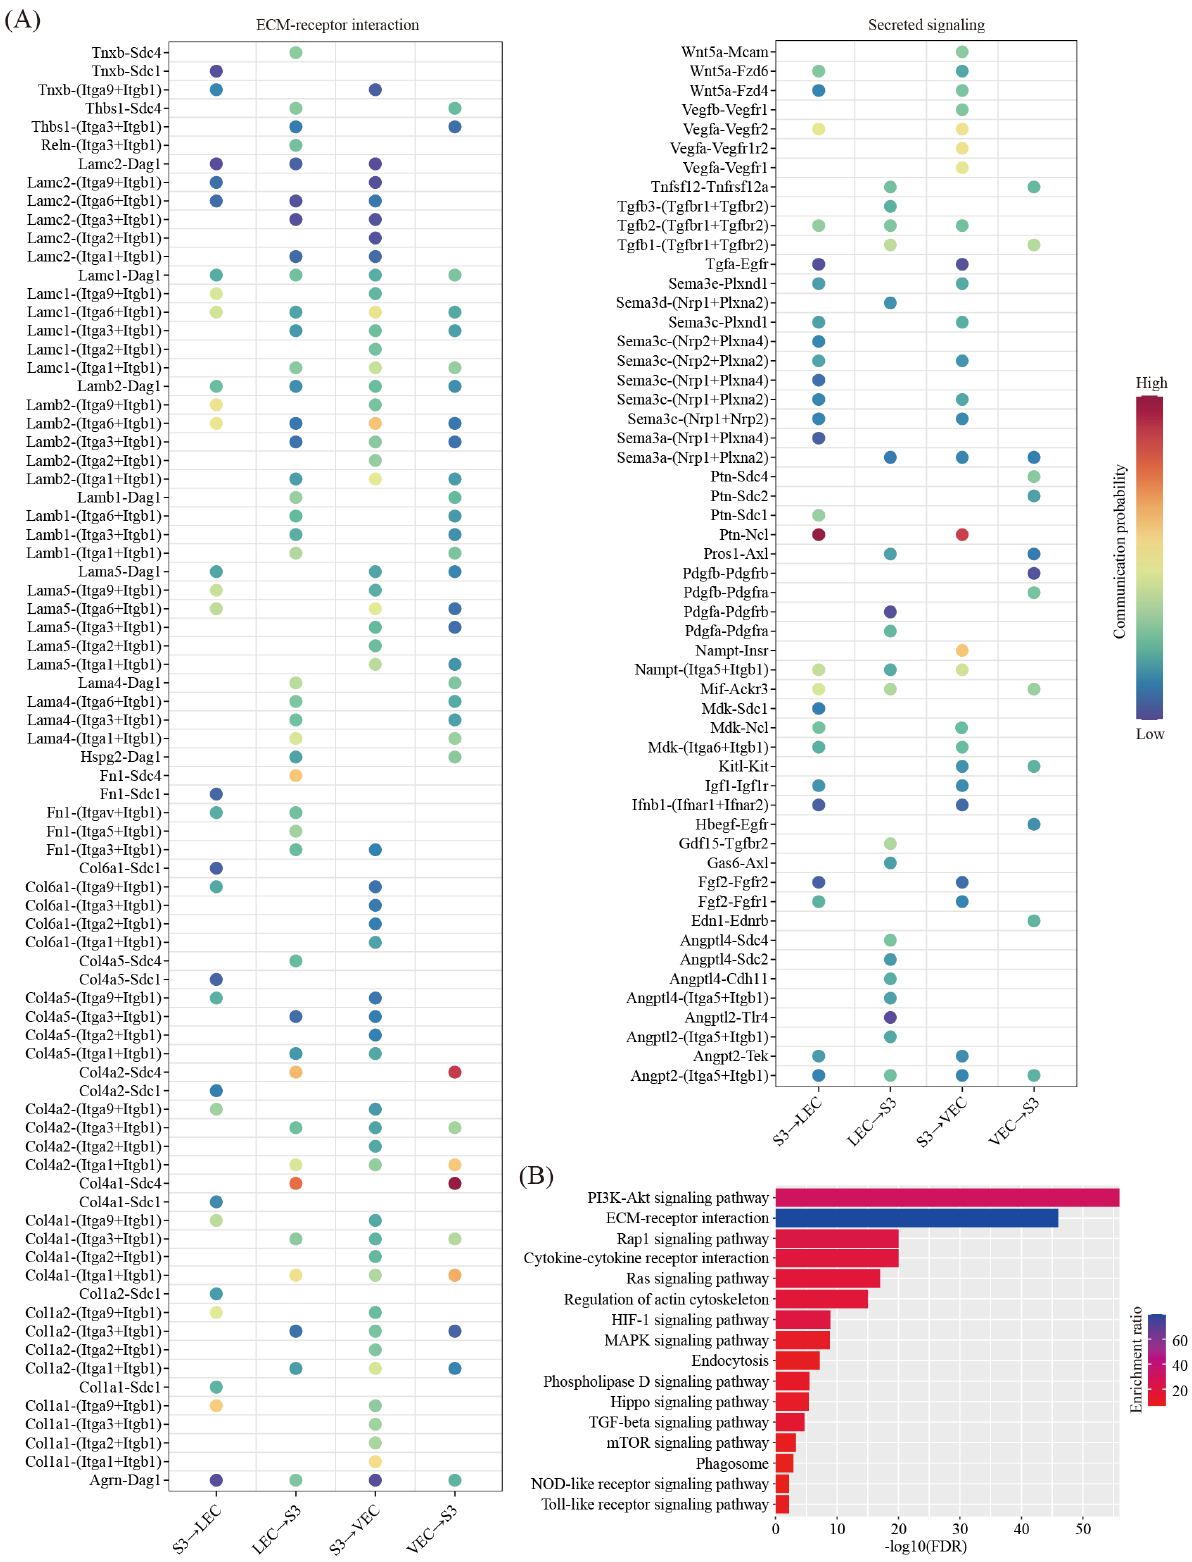
Figure 7. Cell–cell communication between decidual cells and endothelial cells. ( A ) Dot plot showing selected ligand- receptor interactions underlying the crosstalk between decidual cells (S3) and endothelial cells (VEC and LEC). The communication probability defined by the CellChat software were indicated by color. ( B ) KEGG pathway enrichment analysis of ligand-receptor pairs by using the Metascape online tools.